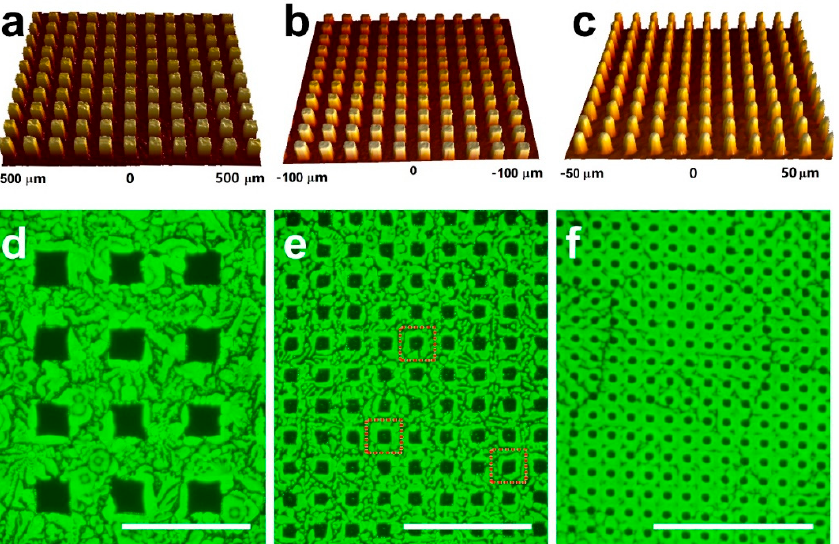
Figure 2. 3D topological images ( a – c ) and optical microscope images ( d – f ) of the template PR grat- ing and the finished crystalline MAPbBr 3 grid for periods of 50 μ m, 20 μ m, and 10 μ m, respectively. and the finished crystalline MAPbBr 3 grid for periods of 50 µ m, 20 µ m, and 10 µ m, respectively. The The scale bars denote a same length scale of 80 μ m. scale bars denote a same length scale of 80 µ